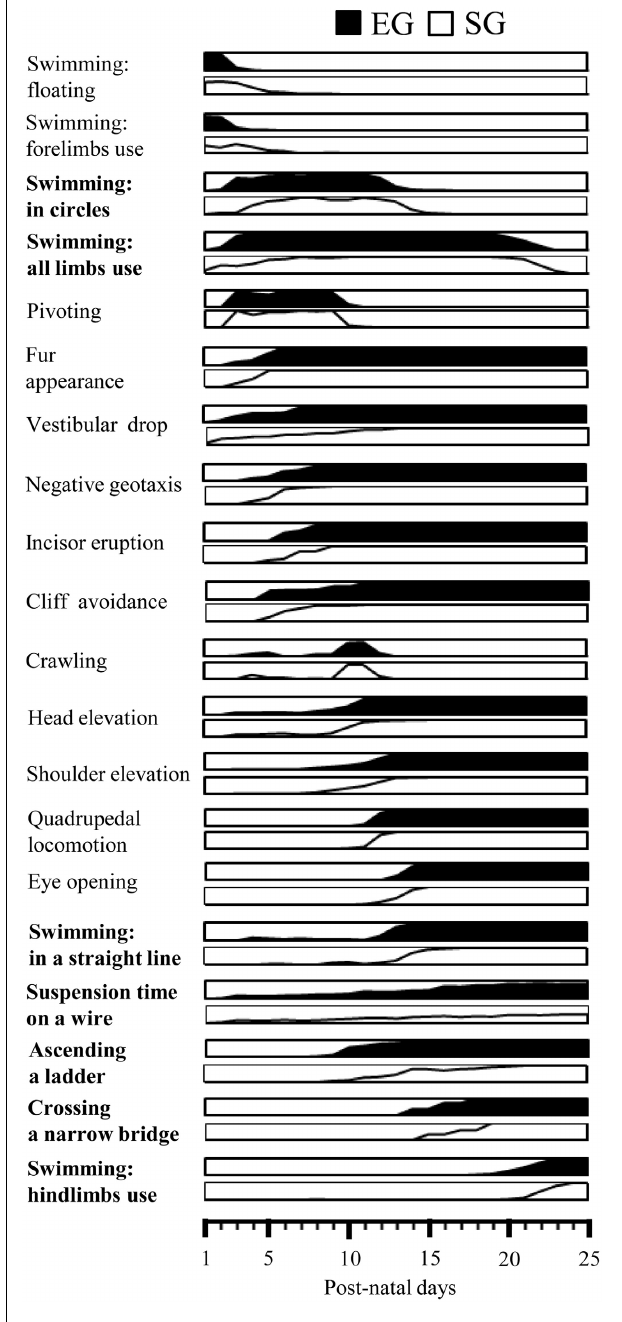
FIGURE 9 | Summary diagram of motor development of EG and SG pups. Global timing of physical development (fur appearance, incisor eruption, eye opening), reflex appearance (vestibular drop, negative geotaxis, cliff avoidance), development of quadrupedal stance (head elevation, shoulder elevation) and locomotion (pivoting, crawling, quadrupedal locomotion) and acquisition of complex motor abilities (swimming, suspension on a wire, ascending a ladder, crossing a narrow bridge) in EG (black area) and SG (white area) pups. The behaviors significantly different between groups are indicated in bold. In each diagram the percentage of animals progressively showing the behavior are